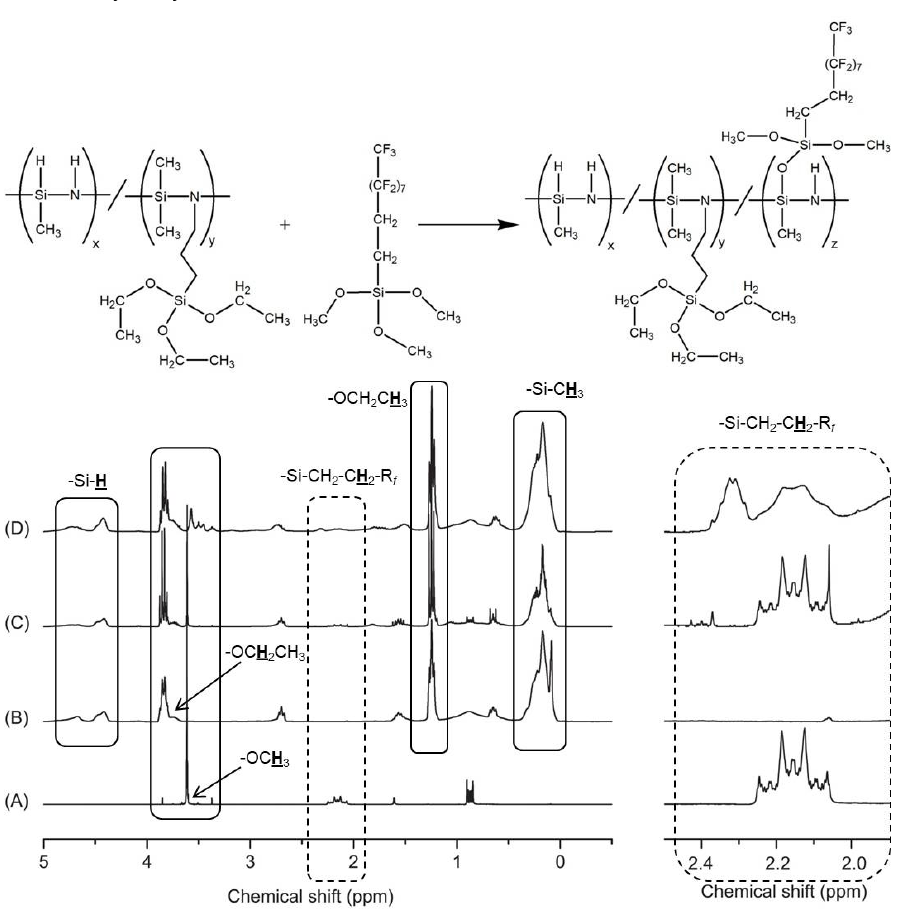
Figure 2. 1 H-NMR spectra of ( A ) FAS-17, ( B ) OPSZ, ( C ) the initial mixture of the reactants, and ( D ) FPSZ 17.3 .